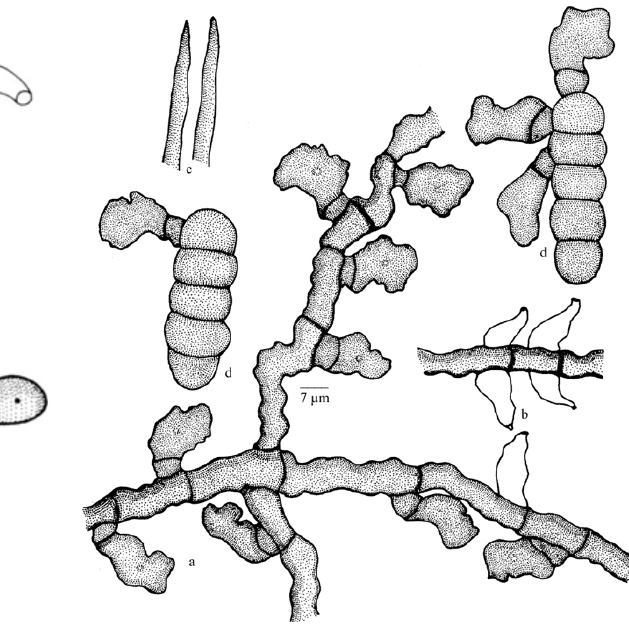
Figure 84. Meliola jasmini var. microspora a - Appressorium; b - Phialide; c - Apical portion of mycelial setae; d - Ascospores